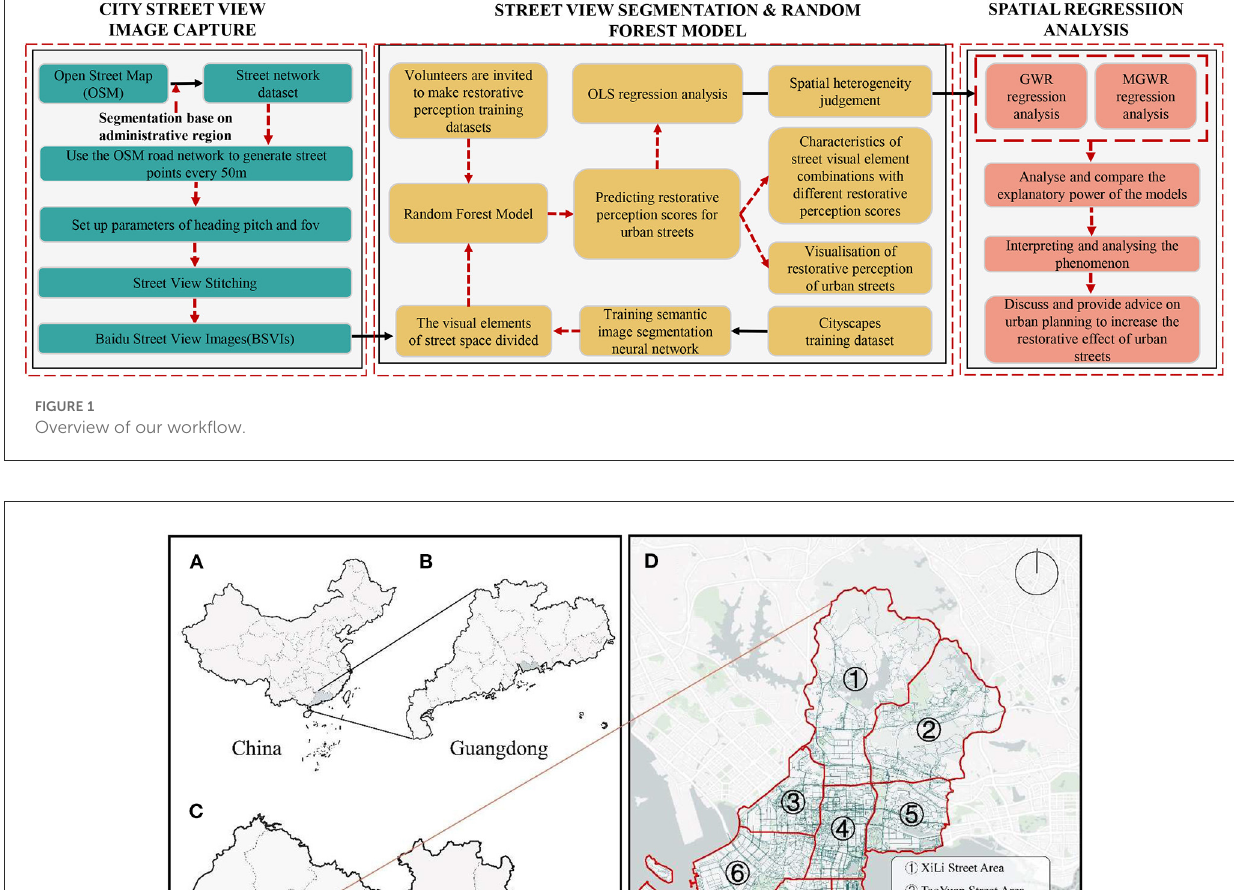
and 6 means the description matched the volunteer’s